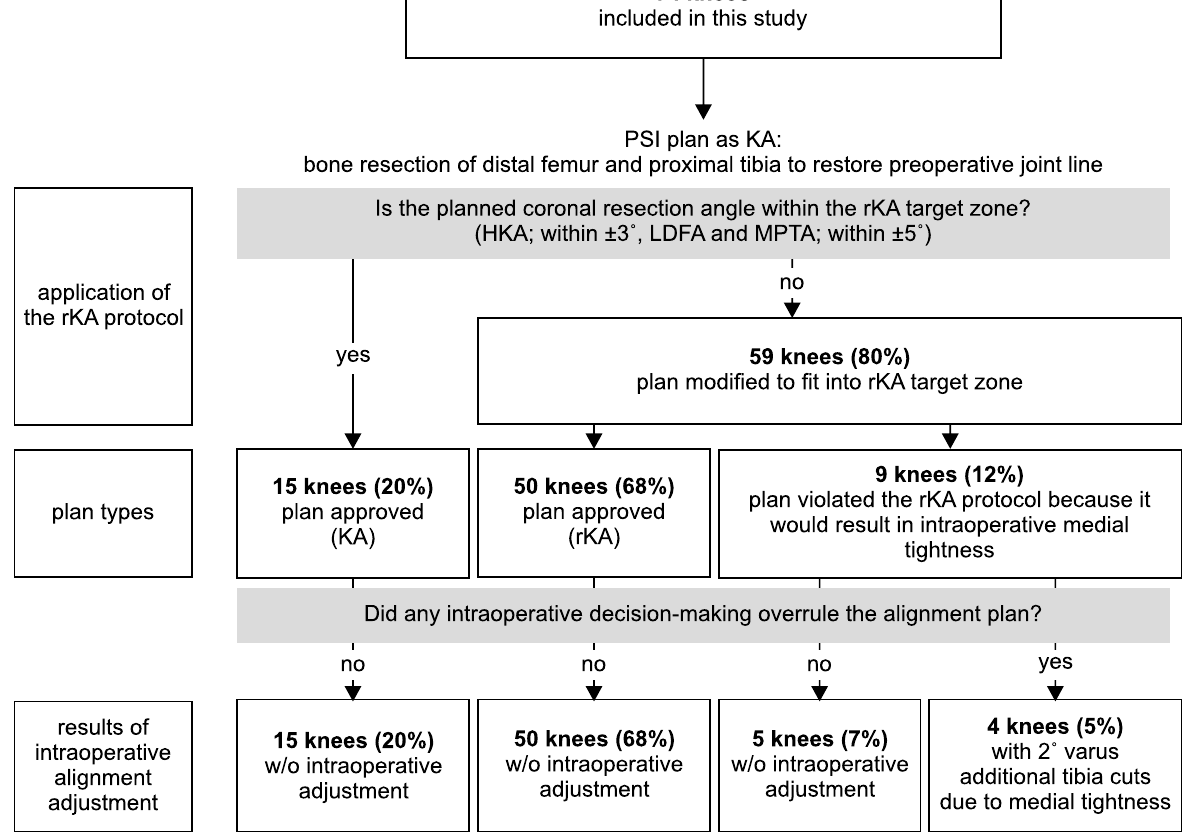
Fig. 5 Flowchart showing the number of patients who had modifications to or deviated from the rKA plan and the results of intraoperative alignment adjustment Abbreviations: HKA: hip-knee-ankle angle; KA: kinematic alignment; LDFA: lateral distal femoral angle; MPTA: medial proximal tibial angle; PSI: patient-specific instrument; rKA: restricted kinematic alignment